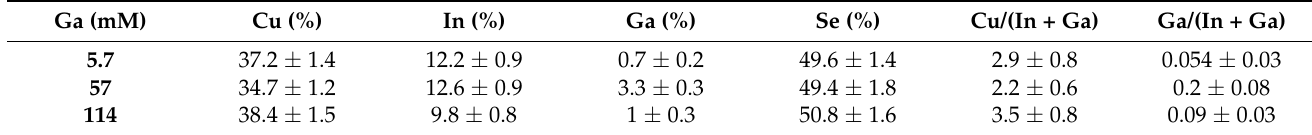
Table 4. EDS analysis of CIGS NWs obtained in different